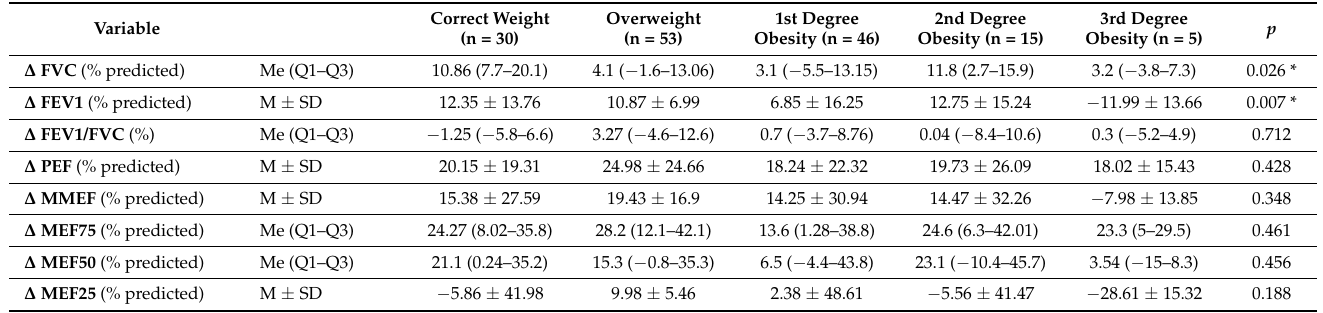
Table 7. Relationships between the difference in spirometric results before and after rehabilitation and BMI.